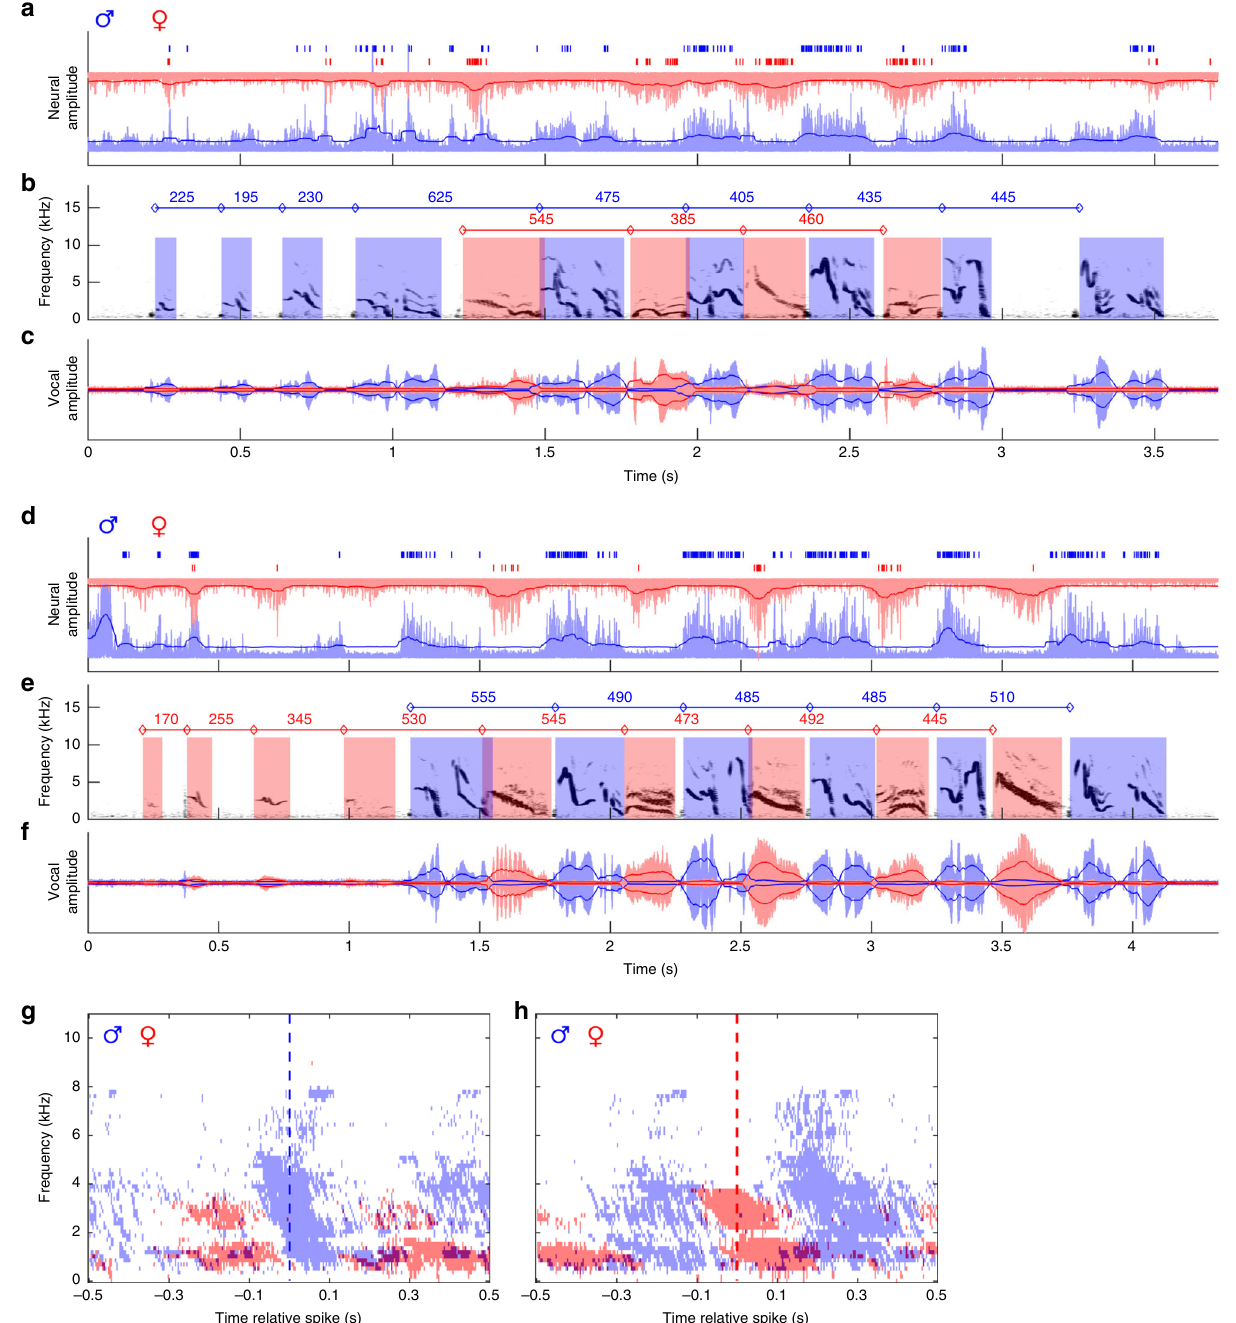
Fig. 4 Vocalizations are locked to bursts of premotor HVC activity in the singing bird. Throughout, male signals are coded in blue and female signals are coded in red. The fi ltered and recti fi ed male and female neural traces ( a , d ) and the spectrogram ( b , e ) and amplitude waveform ( c , f ) of the combined male and female vocal traces are shown for exemplary duet bouts initiated by the male ( a ) or by the female ( d ) of Pair #5. Solid dark blue and dark red lines outline the root-mean-square envelope (see “ Methods ” ) of neural and vocal signals. Times of spike occurrence are indicated by short vertical lines above the neural traces. Onset – onset intervals of male and of female duet syllables are provided by values above the spectrograms. Please note the precise alternation of neural bursts between interacting males and females. Signi fi cant ( p < 0.01, t test) activity in the averaged spectrogram (see “ Methods ” ) of male and female vocal signals within a window of 500 ms before and after the time of occurrence of 3000 male ( g ) and 3000 female ( h ) spikes that occurred during 46 duet bouts of Pair #5 is shown by clusters of blue and red time – frequency pixels. The dashed blue and red lines mark the time of occurrence of male and female spikes, respectively, used for generation of the averaged